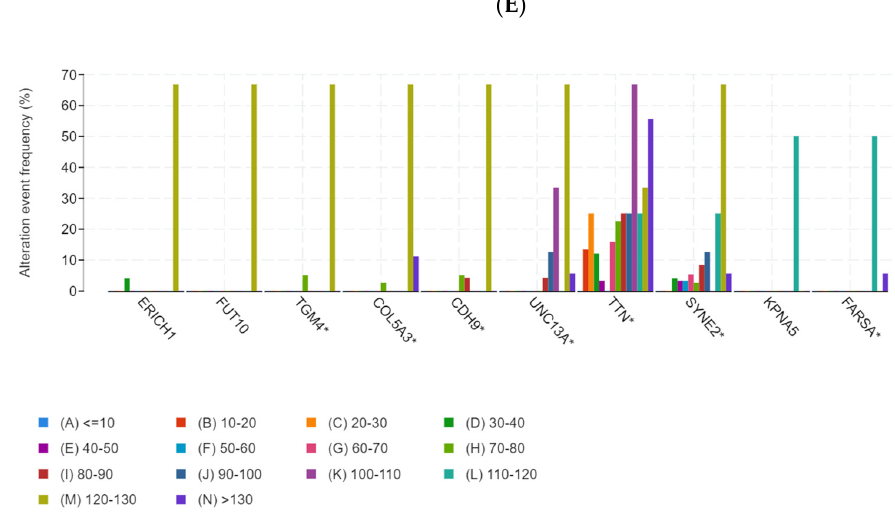
Figure 2. Identification of potential tumor antigens of PRCC. ( A ) Upregulated genes in PRCC mapped onto human chromosomes. ( B , C ) Number of samples in the altered fraction genome group and mutation count group, respectively. ( D ) Top ten alteration event frequencies in the fraction genome altered group. ( E ) Top ten alteration event frequencies in the mutation count group.